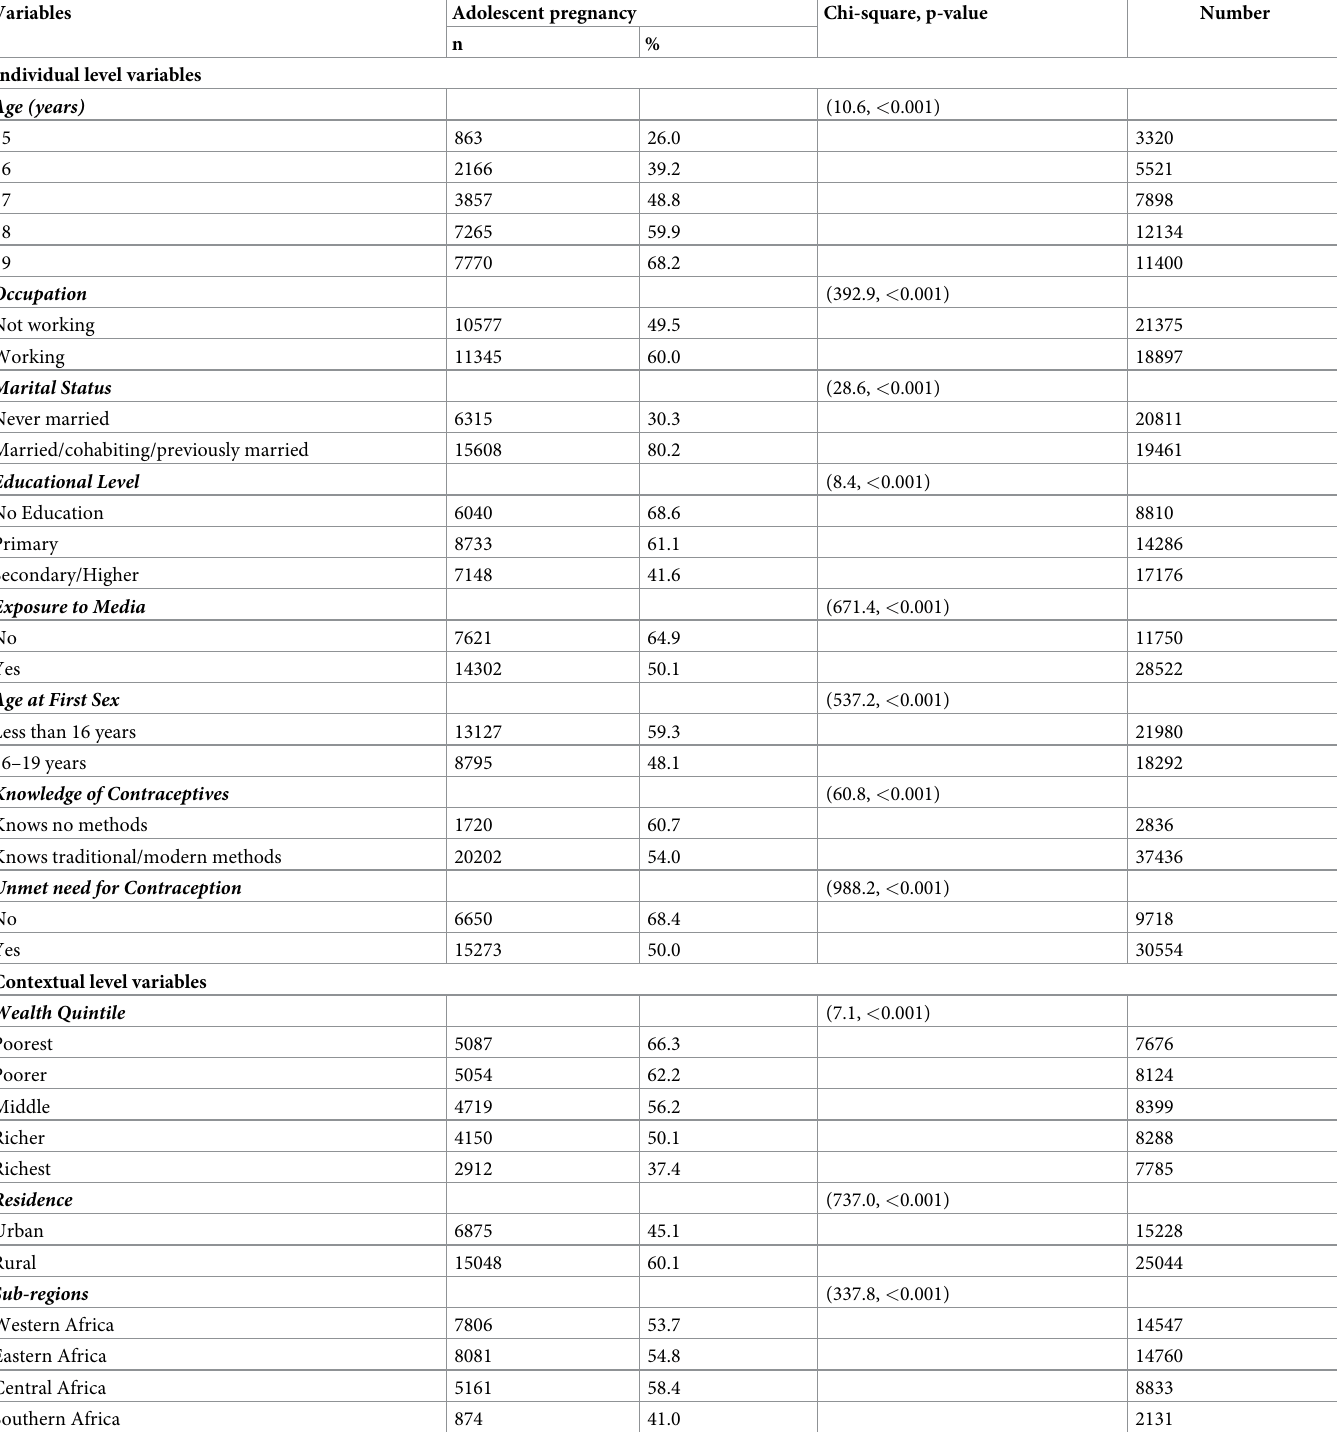
Table 2. Relationships between individual and contextual variables, and first pregnancy in adolescents who had ever had sex (DHS,